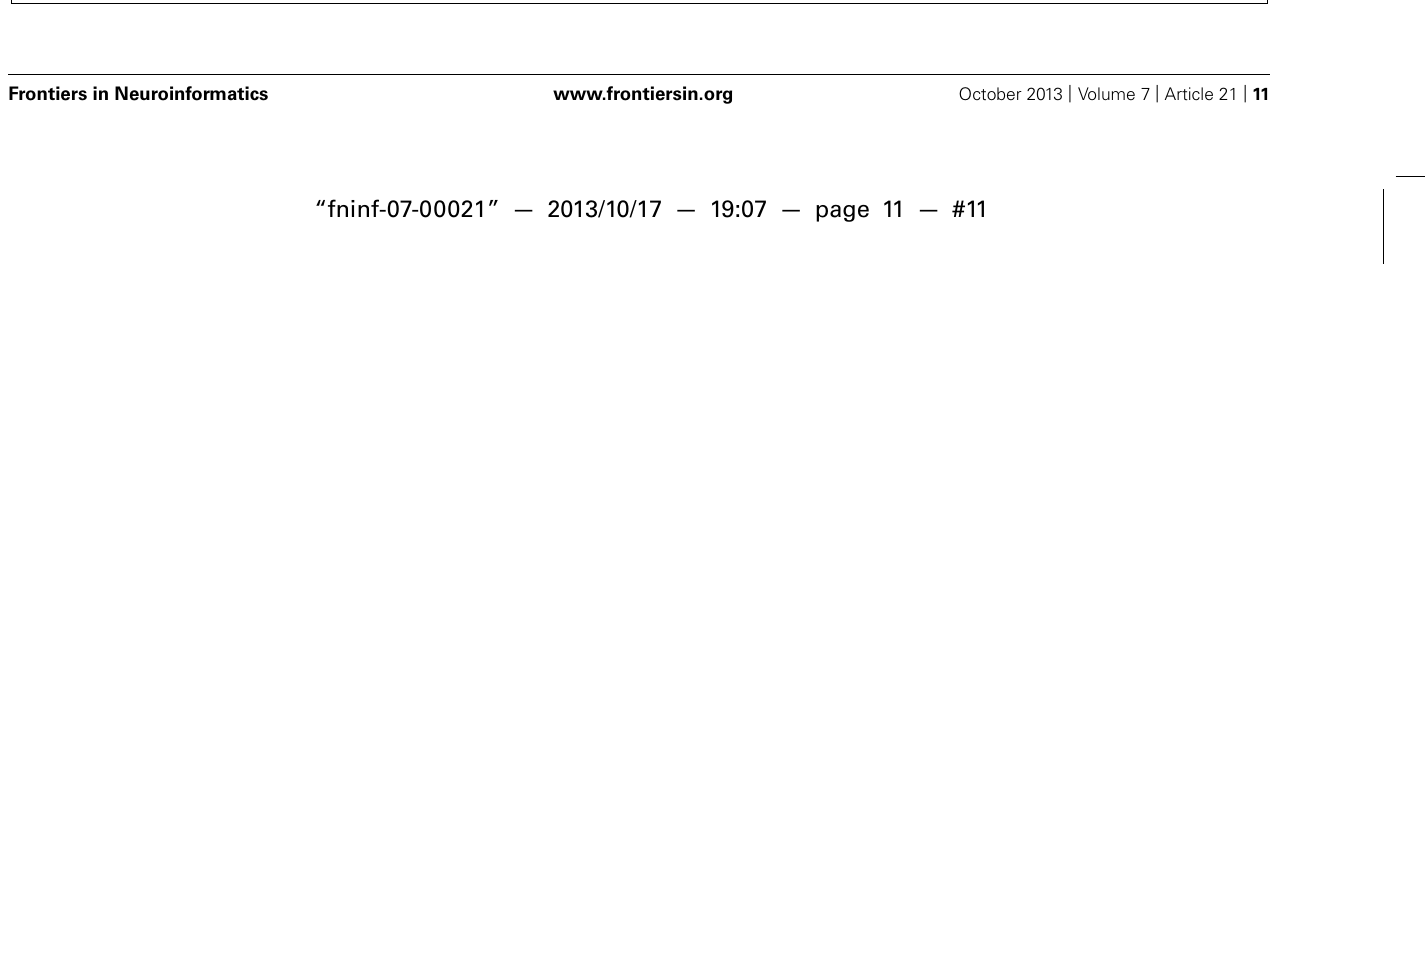
FIGURE 10 |A processing log for an example data set for which the CBF processing was done six times, each with a unique set of CBF processing options. The table at the bottom lists all jobs and processing options used for each, allowing the user to easily compare differences between